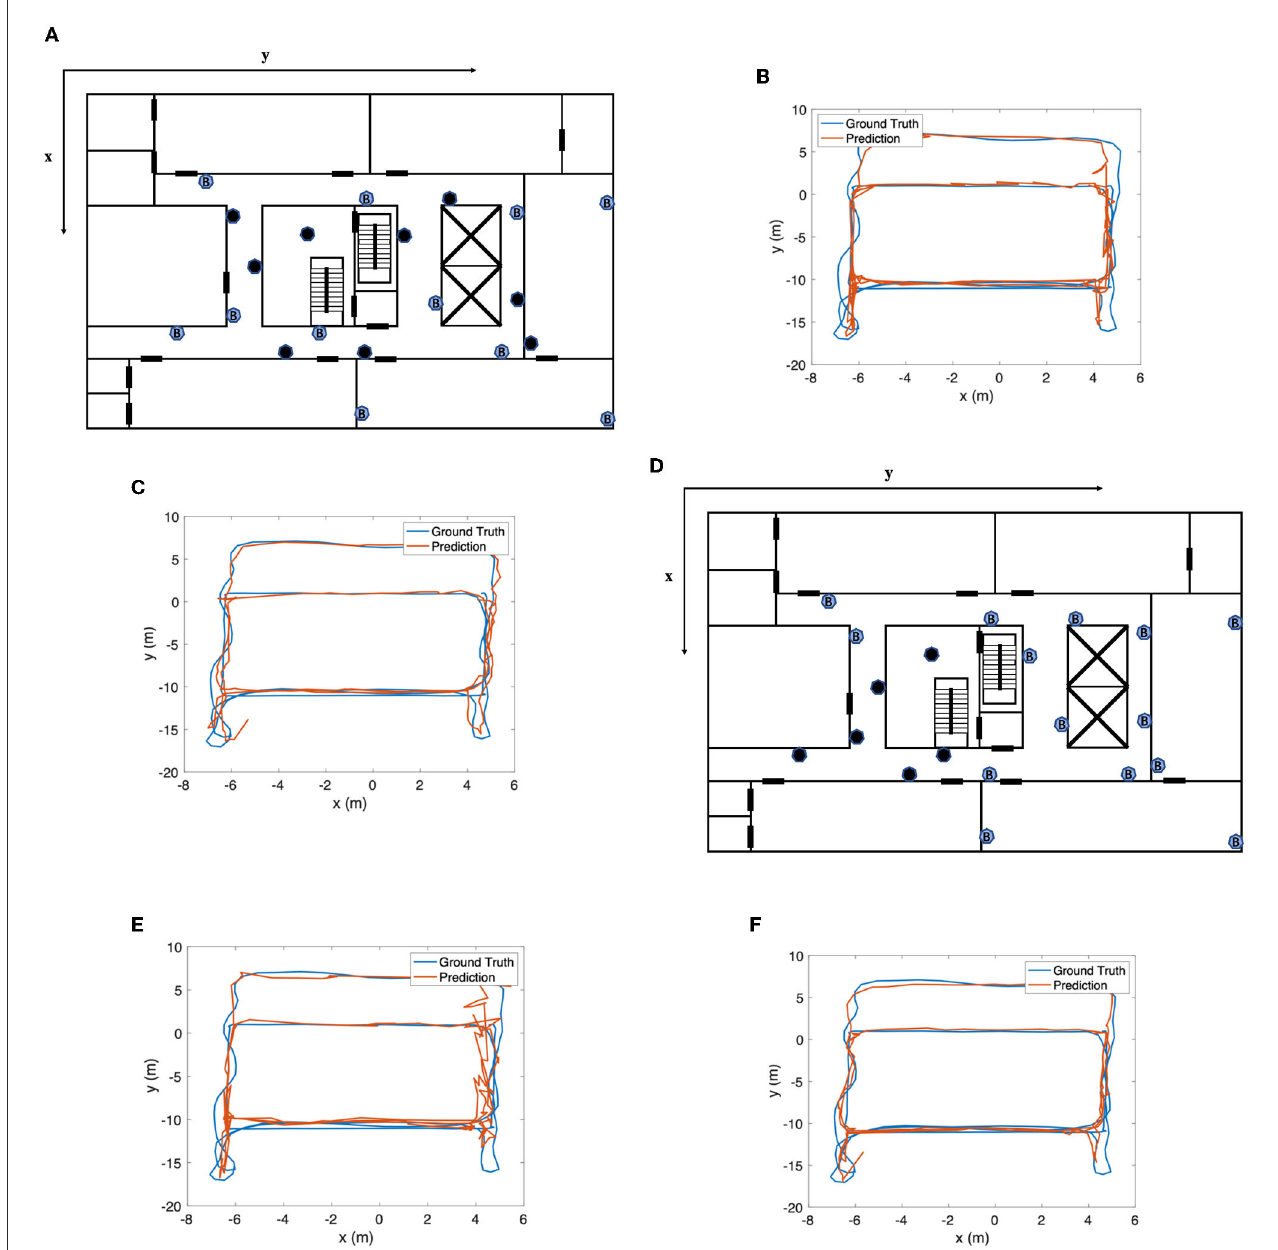
FIGURE11 (A) Beacon layout for circumstance 1. (B) Wireless encoder result for circumstance 1. (C) SmartFPS result for circumstance 1. (D) Beacon layout for circumstance 2. (E) Wireless encoder result for circumstance 2. (F) SmartFPS result for circumstance